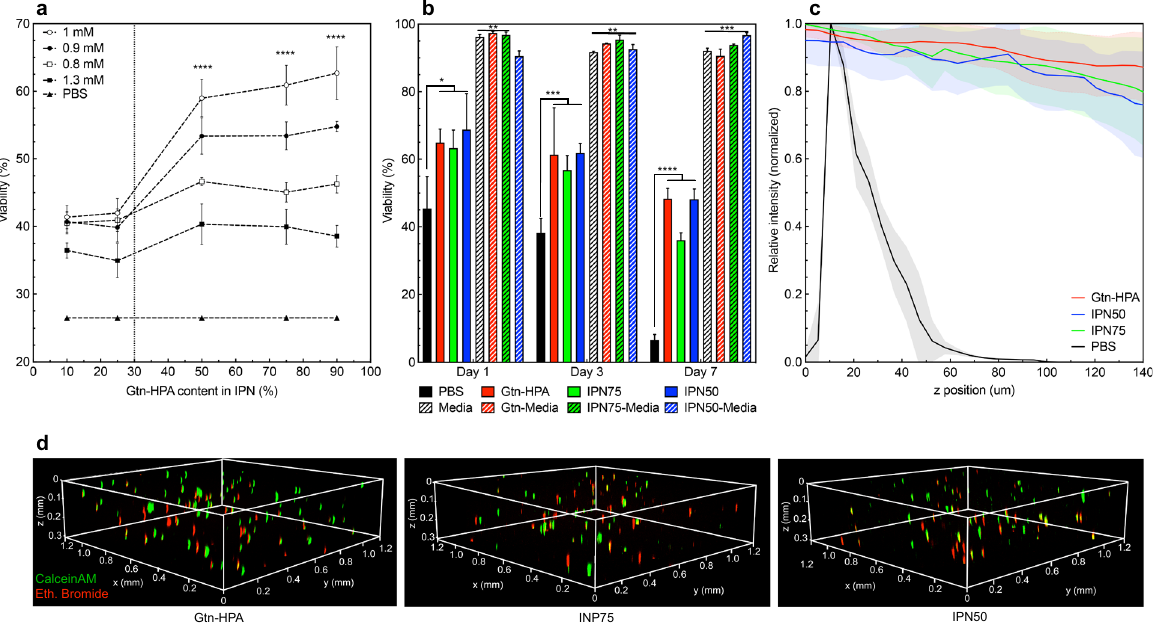
Fig. 2 Optimal interpenetrating network candidates for human retinal ganglion cells viability, encapsulation, and in vivo release. a Viability assay at day 3 of encapsulated human retinal ganglion cells in IPN with different Gtn-HPA content and a range of crosslinker concentration compared with PBS. Data were measured for 10 fi eld of views of live/dead staining. Data shown as mean ± SEM and one-way ANOVA followed by student t test was performed showing a statistically high signi fi cant difference between H 2 O 2 -1mM and all others for more than 50% Gtn-HPA in the IPN (**** p < 0.0001). b Viability assay through the time of encapsulated hRGC in hydrogel candidates (Gtn-HPA, IPN75, and IPN50) with media or PBS. Plain bars show cells deprived from nutrients while hashed bars represent cells in their de fi ned medium. Data shown as mean ± SEM of triplicate wells with 15 different fi elds. Two-way ANOVA, followed by Tukey ’ s test, was performed and shows a statistically high signi fi cant difference between samples including media and all other groups (** p = 0.005 and *** p = 0.0001) at all time points; and between hydrogels groups deprived from nutrients compared to PBS (* p = 0.01 and **** p < 0.0001). c Relative fl uorescence intensity of hRGC stained with live/dead assay, imaged with confocal microscopy for Gtn-HPA, IPN75, IPN50, and PBS, on 150 um thick slides, in the function of their z position. d. 3D fl uorescence image of live (CalceinAM-green) and dead (Ethidium Bromide-red) hRGC encapsulated in the hydrogel candidates, imaged with confocal microscopy on 1.2×1.2×0.3 mm samples. All images were taken at 10X magni fi cation under fl uorescence